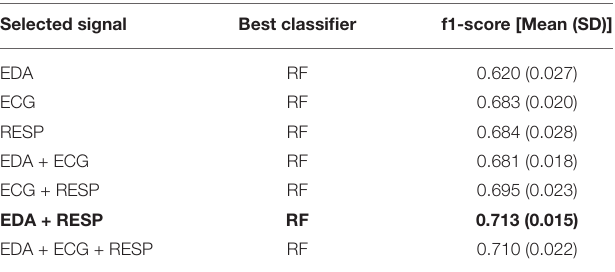
TABLE 6 | Best score achieved by the model to predict task difficulty for each combination of physiological signals. Selected signal Best classifier f1-score [Mean